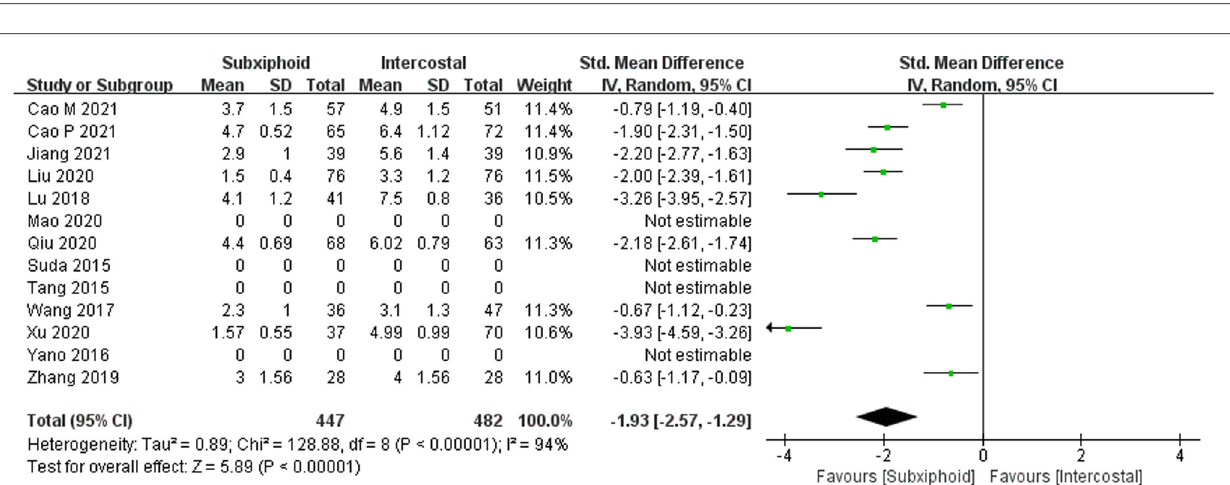
FIGURE 8 | Forest plot of the role of SMD and its 95% CI of postoperative hospital stays between SVATS and IVATS groups.